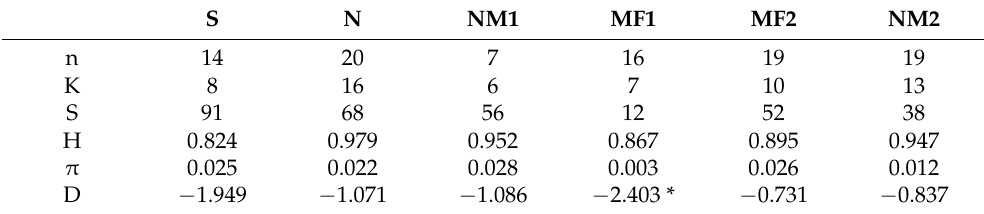
Table 5. Genetic variability of cytb in the Liolaemus monticola chromosome race samples (S: Southern; N: Northern; NM1: Northern Modified 1; MF1: Multiple Fissions 1; MF2: Multiple Fissions 2; NM2: Northern Modified 2). Sample size (n), number of haplotypes (K), number of segregating sites (S), haplotype diversity (H), nucleotide diversity ( π ), and Tajima’s D statistic for each L. monticola chromosomal race. *: p <